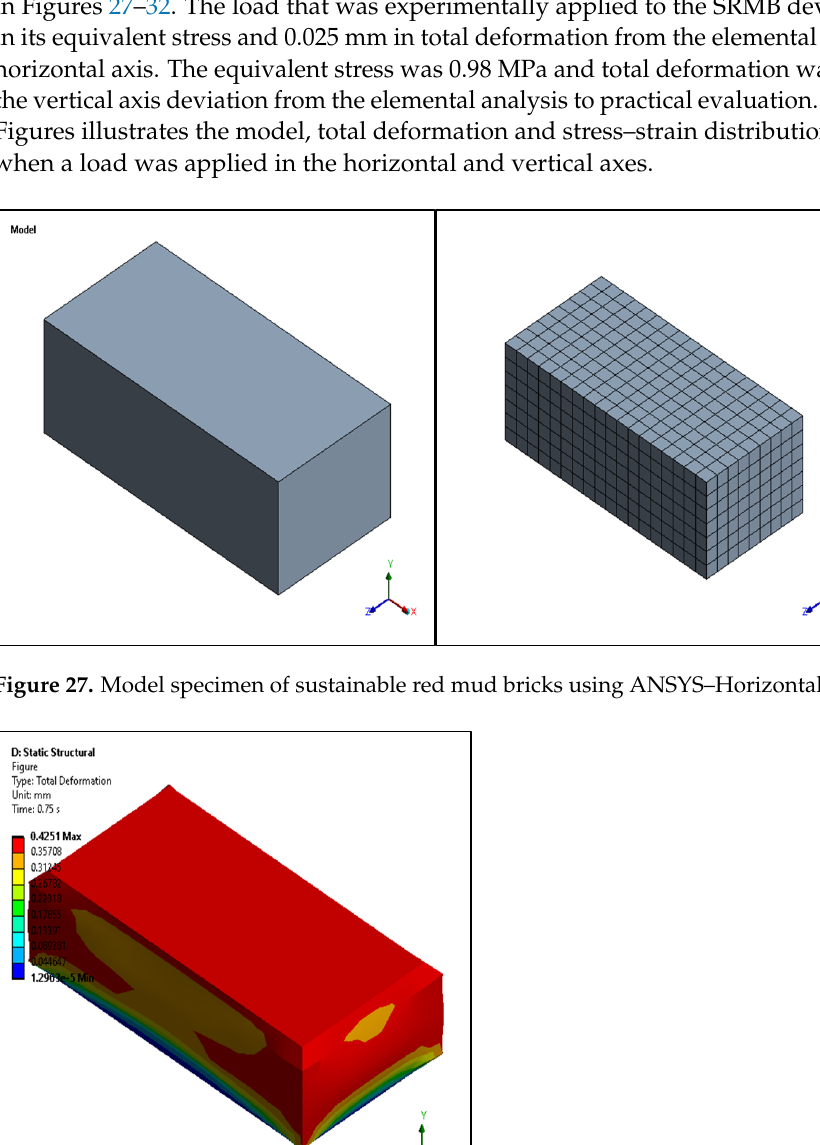
Figure 26. Fourier-transform infrared spectroscopy of sustainable red mud bricks.